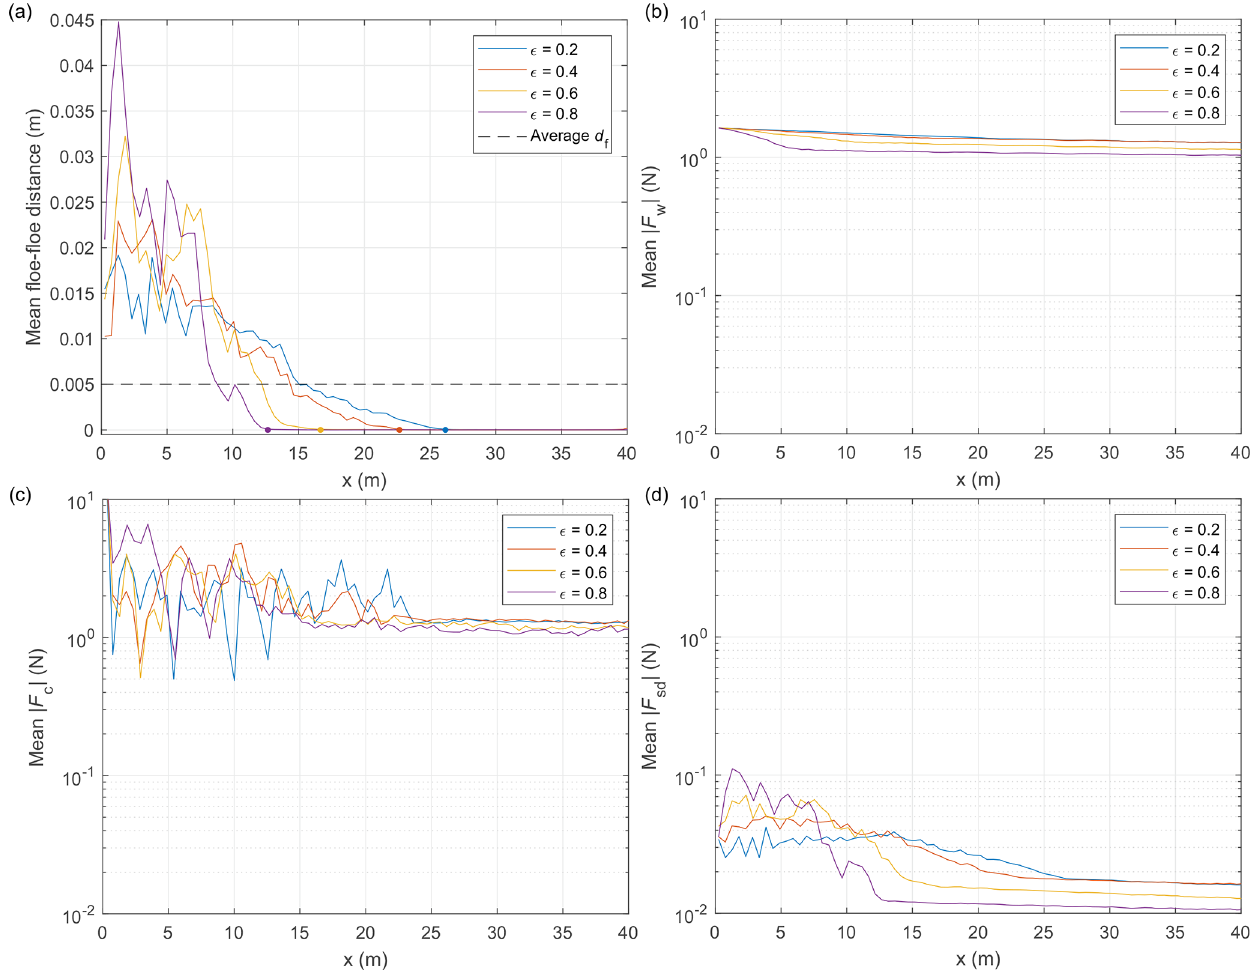
Figure 3. Results of simulations with L x = 0 . 5m, T = 1 . 2s, a 0 = 0 . 0125m, and d f = 0 . 005m, with ML dispersion relation (as in Fig. 2a): mean floe–floe distance (a) , mean | F w | (b) , mean | F c | (c) , and mean | F sd | (d) for four values of restitution coefficient ε . In (a) , black dashed line shows the domain average d f , and dots mark locations where the average floe–floe distance drops below 10 − 4